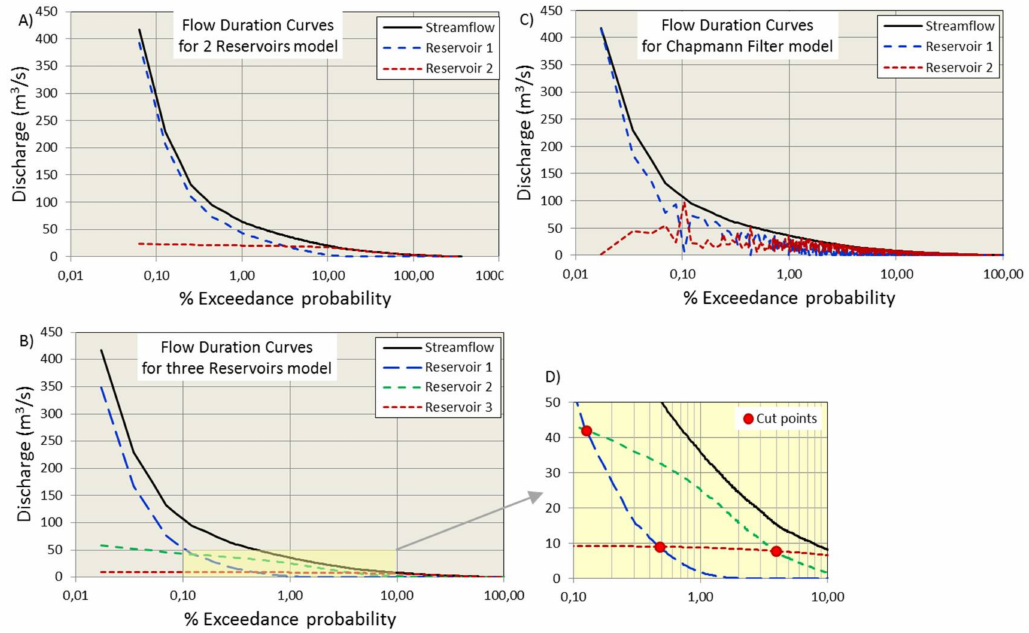
Figure 8. Flow duration curves (FDCs) for two reservoir (2R), three reservoir (3R) and Filter model; ( A ) flow duration curves for two reservoirs model; ( B ) flow duration curves for three reservoirs model; ( C ) flow duration curves for Chapmann Filter model; ( D ) the cut-off points for the 3R model in